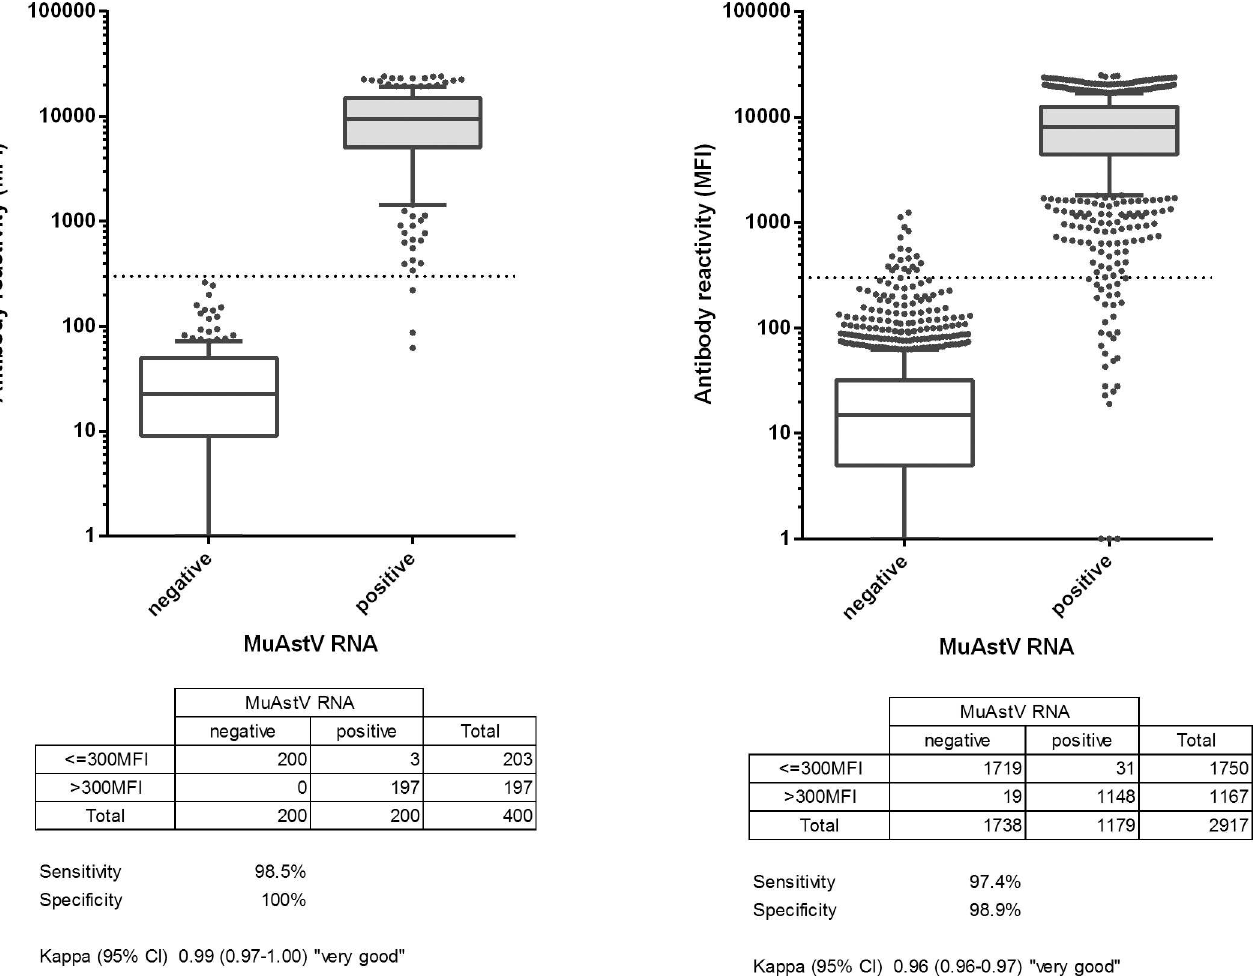
Fig 3. Box plots of net median fluorescence intensity values of test and validation set obtained by multiplex MuAstV serology. The line inside the boxes representsthe median,the boxes are delimitedby the first and third quartile, and whiskersshow the 10 th and 90 th percentile.The horizontaldotted line indicatesthe antigenspecific cut-off value that gives the optimaldiagnosticsensitivity and specificity. The MuAstV capsid protein VP27 in the test and validation set showed highly significantdifferencesof positive versus negative sera (P < 0.001, Mann-Whitney Rank Sum test). Receiveroperatorcharacteristic (ROC) analysisand determination of diagnosticsensitivity and specificity were calculatedusing serum samples from an infected and an uninfectedpopulationdefinedby PCR results. In each panel,the white box plots on the left represent the negative sample set and the grey box plots on the right the positive sample set. (A) Test set (n = 400), (B) Validationset (n = 2917) (S2 Dataset).